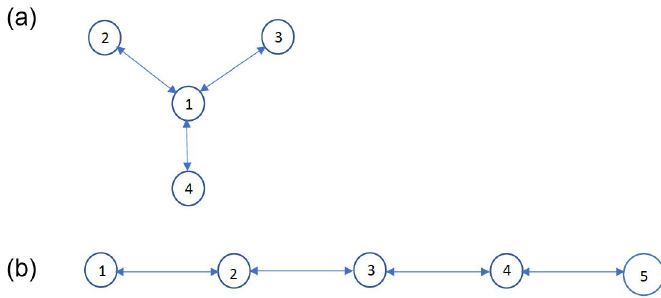
Fig 5. Two example topologies. (a) Star topology. (b) Linear